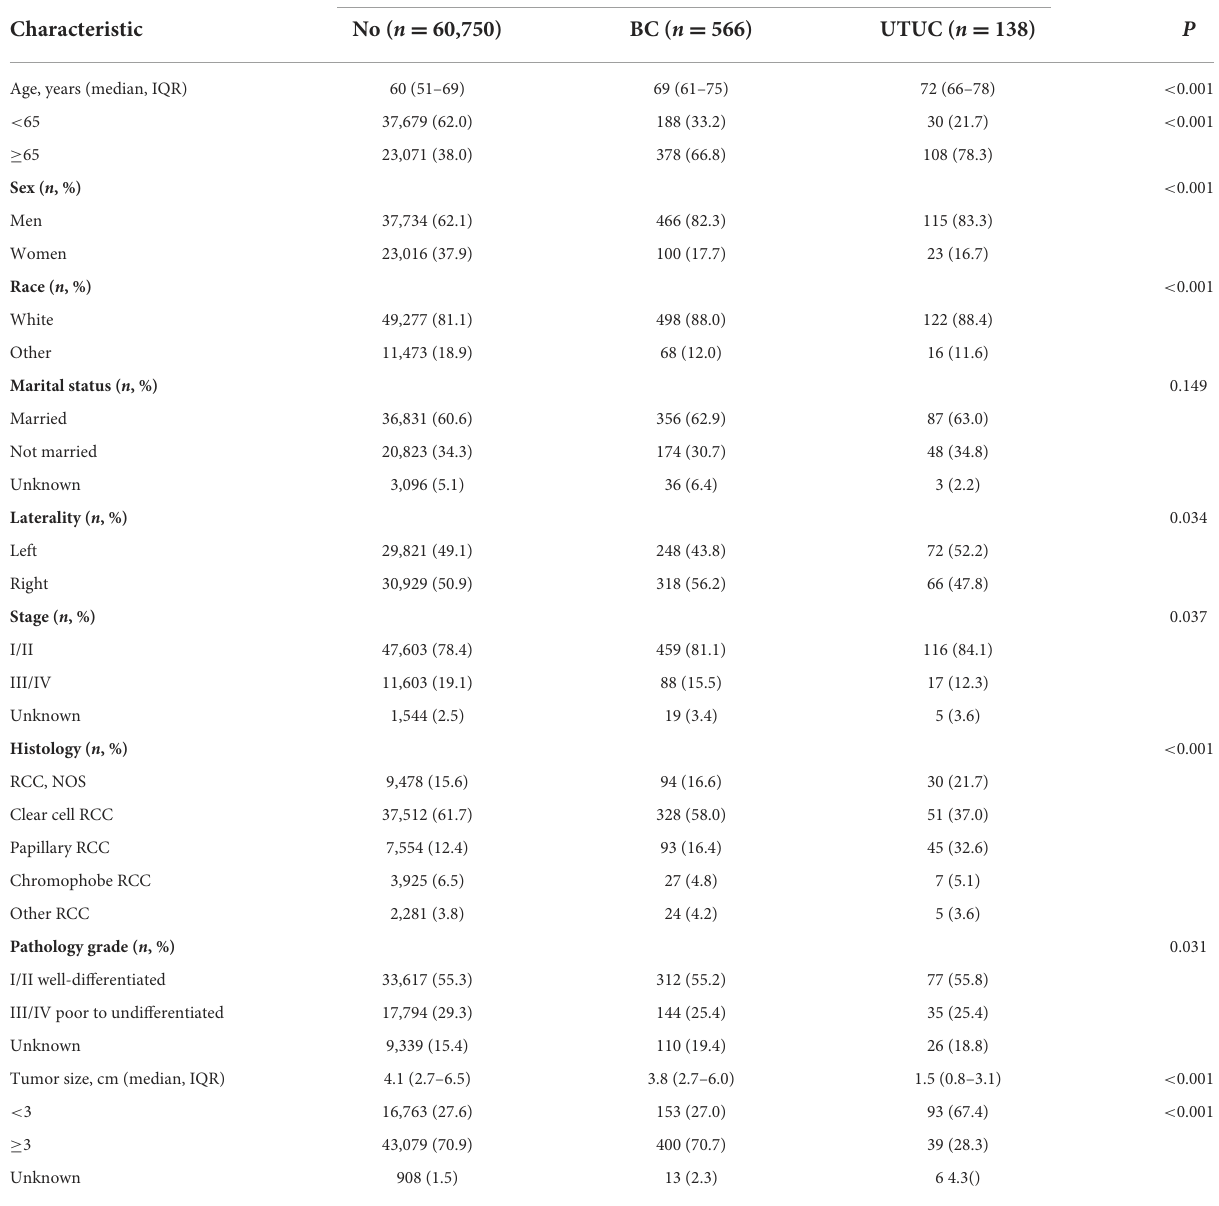
TABLE 1 Patient characteristics a